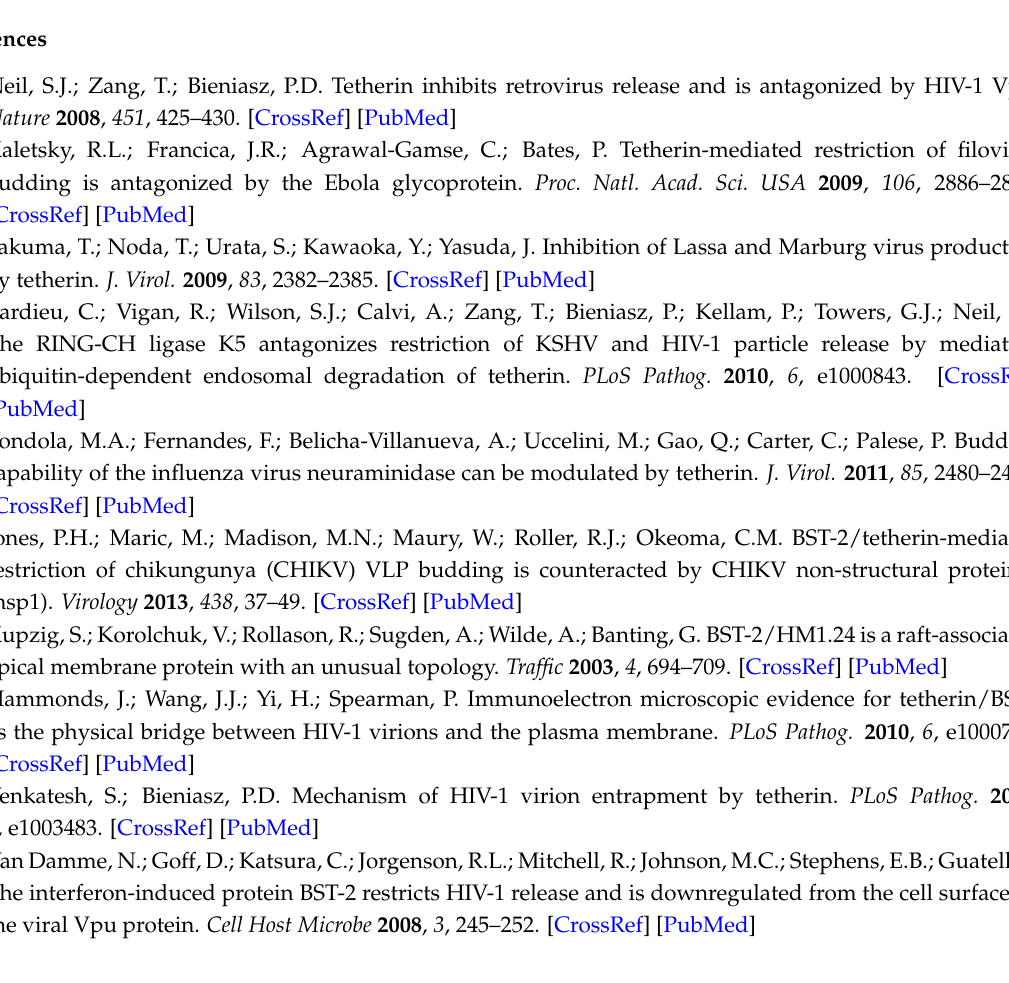
Supplementary Materials: Figure S1: MSD and N-terminal Sequences; Figure S2: GP expression in lysates 1; Figure S3: GP expression in lysates 2; Figure S4: C-terminal cysteines budding assay; Figure S5: mtfr1-tetherin budding